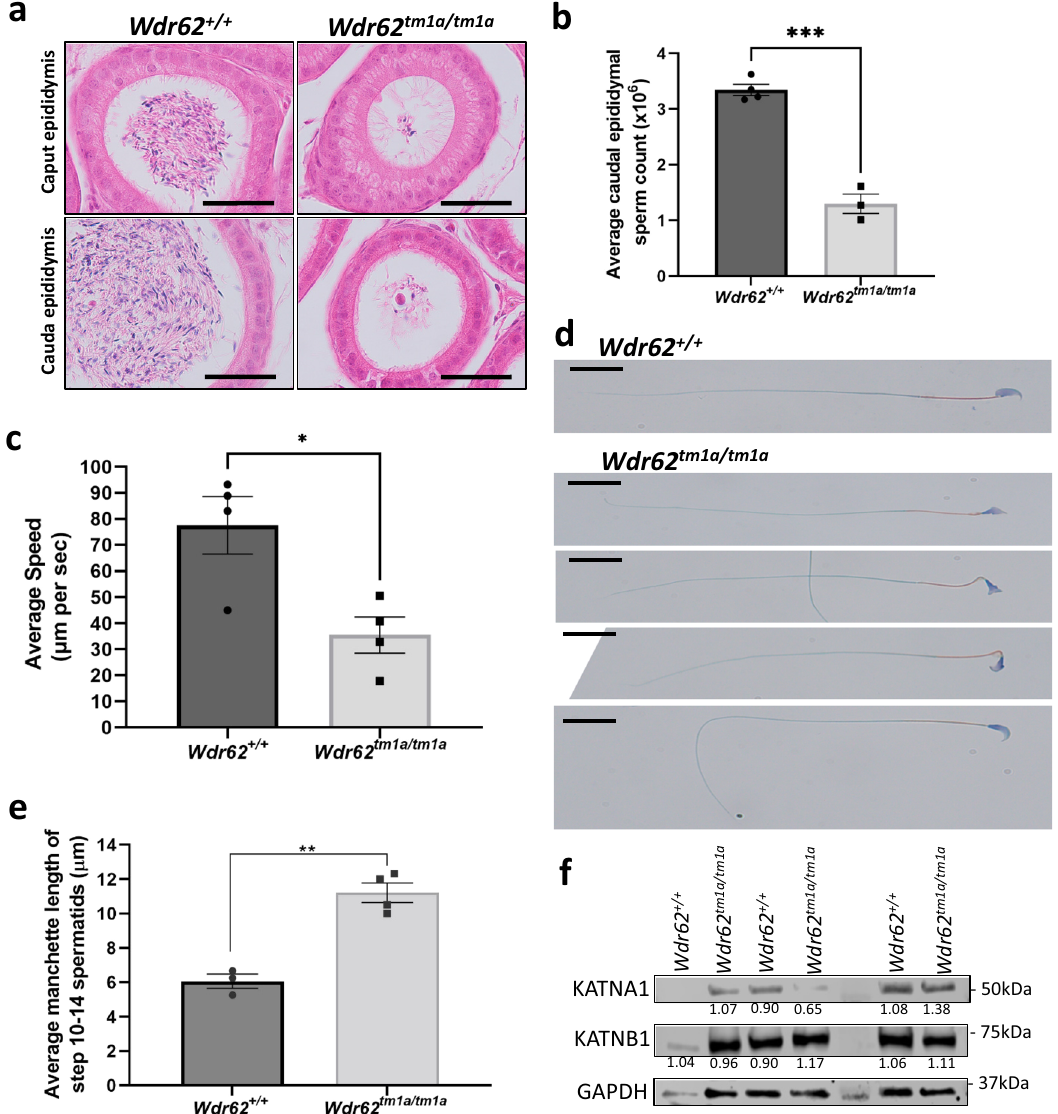
Fig. 5 Wdr62 tm1a/tm1a spermatozoa show oligoasthenoteratospermia. a Haematoxylin and eosin staining of adult Wdr62 + / + and Wdr62 tm1a/tm1a adult epididymis. Scare bar represents 100 μ m. b Hemocytometer quanti fi cation of fi xed cauda epididymal spermatozoa shows reduced sperm counts in Wdr62 tm1a/tm1a . n = 4 Wdr62 + / + and 3 Wdr62 tm1a/tm1a independent adult mice. Two-tailed unpaired Student ’ s t -test, *** p = 0.0001. c Quanti fi cation of sperm motility micrometre swam per second, which showed reduced sperm motility in Wdr62 tm1a/tm1a spermatozoa. N = total 190 spermatozoa analysed from four independent Wdr62 + / + adult mice; and total 101 spermatozoa analysed from four independent Wdr62 tm1a/tm1a adult mice. Two-tailed unpaired Student ’ s t -test, * p = 0.0180. d Sperm stain of adult cauda epididymal sperm smear, which shows normal sperm head (purple), midpiece (orange) and fl agellum (green) in Wdr62 + / + . However, Wdr62 tm1a/tm1a spermatozoa show misshapen sperm heads, with the midpiece and fl agellum appear normal. n